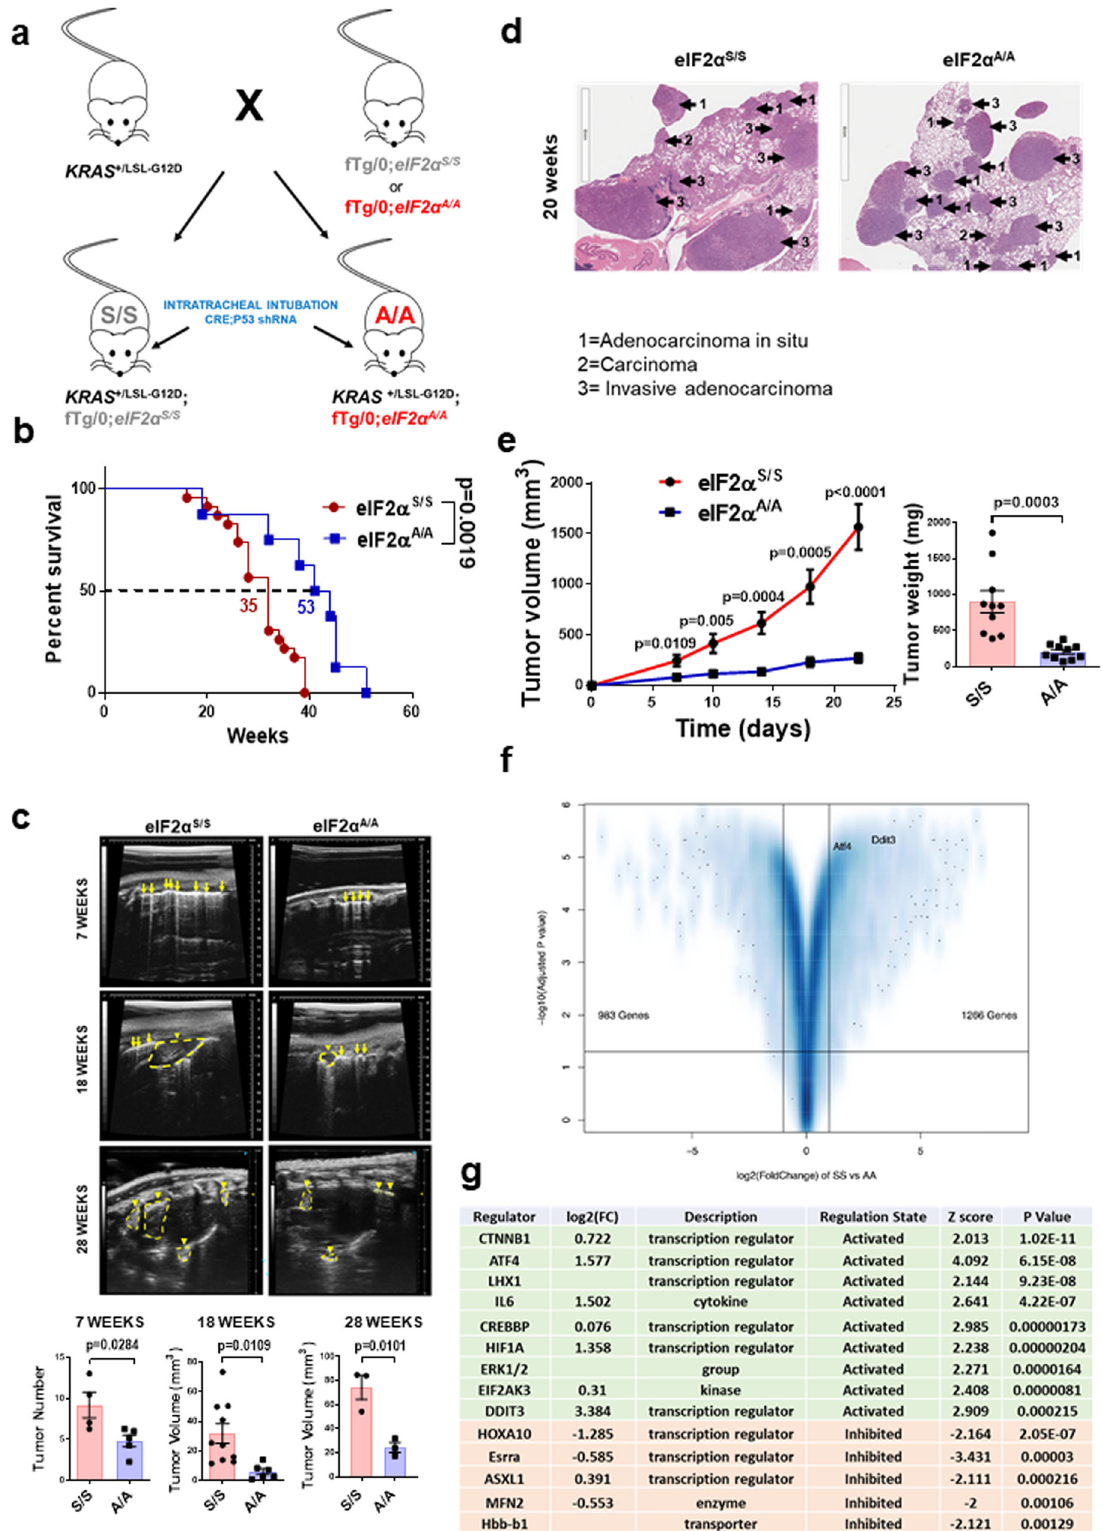
arm in the survival of human LUAD cells. PERK inhibition by GSK2606414, a potent and selective PERK inhibitor among the eIF2 α kinases 31 , caused a stronger reduction in the colony- forming ef fi cacy of human LUAD cells with KRAS G12C than WT KRAS (Supplementary Fig. 7a). The increased susceptibility